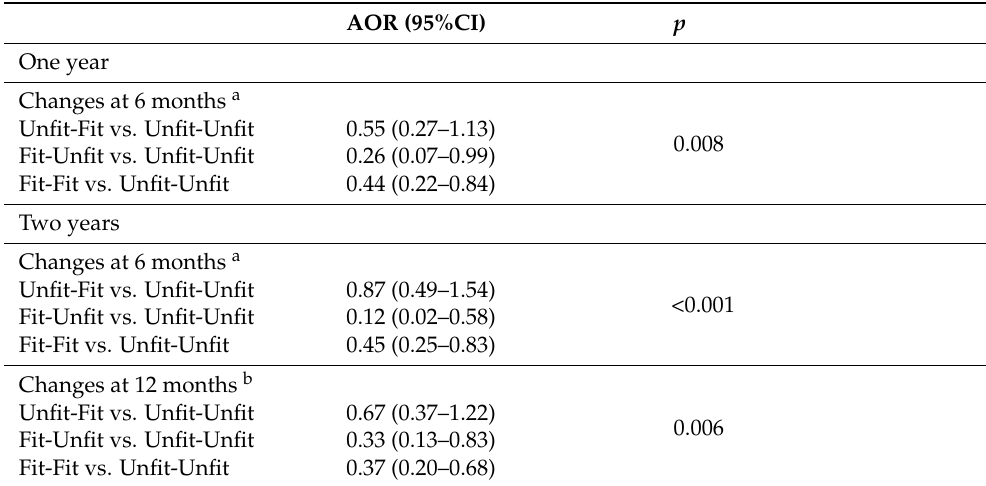
Table 4. Association of changes in cardiorespiratory fitness at six or twelve months with development of abdominal obesity at one or two years: multivariate adjusted odds